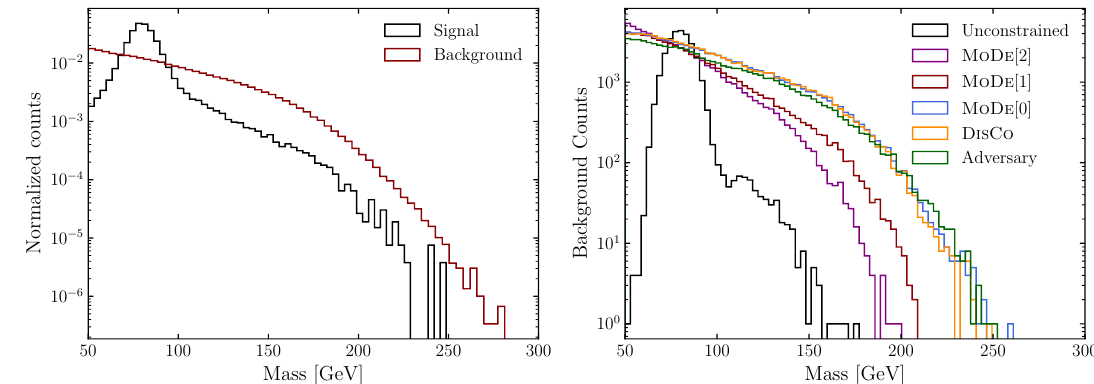
Figure 6 . Left: distributions of signal and background events without selection. Right: background distributions at 50% signal efficiency (true positive rate) for different classifiers. The unconstrained classifier sculpts a peak at the W -boson mass, while other classifiers do not.